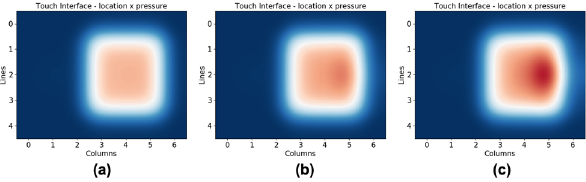
Figure 16: Touch detected in an area of the sensor ( not blue ) and variation in the force applied: ( a ) weak, ( b ) medium and ( c ) the strongest touch.